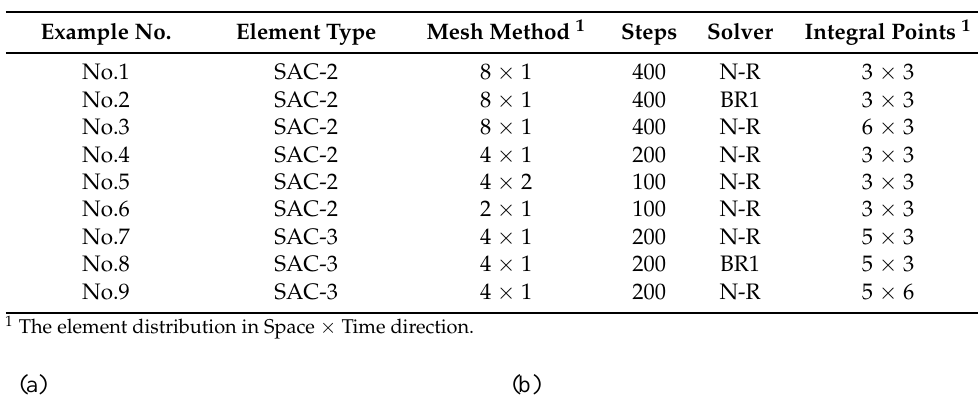
Table 5. Examples to study the influence on efficiency.